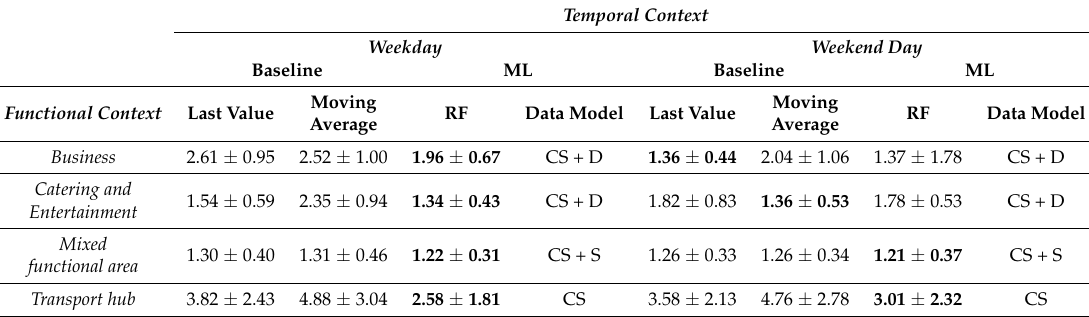
Table 2. Comparison between ML-based and baseline solutions on a larger cell selection for each functional context, in terms of MAE (avg ±